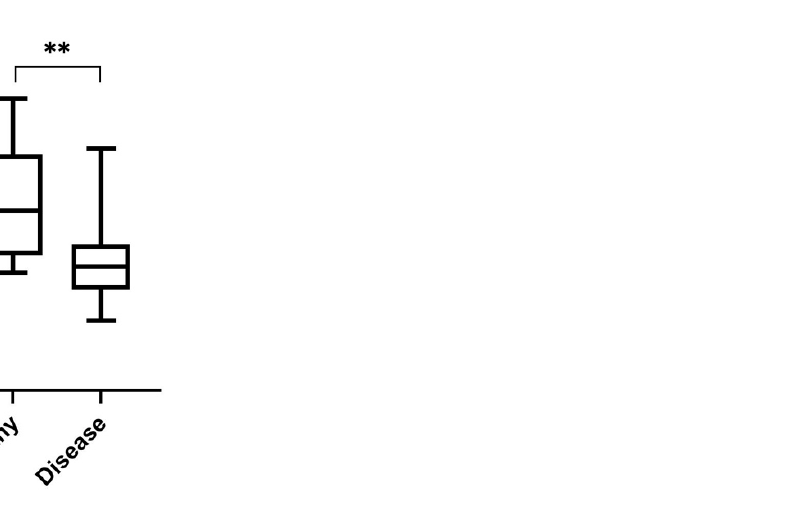
Figure 5. Box plot analysis of serum T-cell immunoglobulin and mucin-domain-containing molecule-3 (TIM-3) levels in healthy cats ( n = 14) and cats with mammary carcinoma ( n = 48) (** p < 0.01).